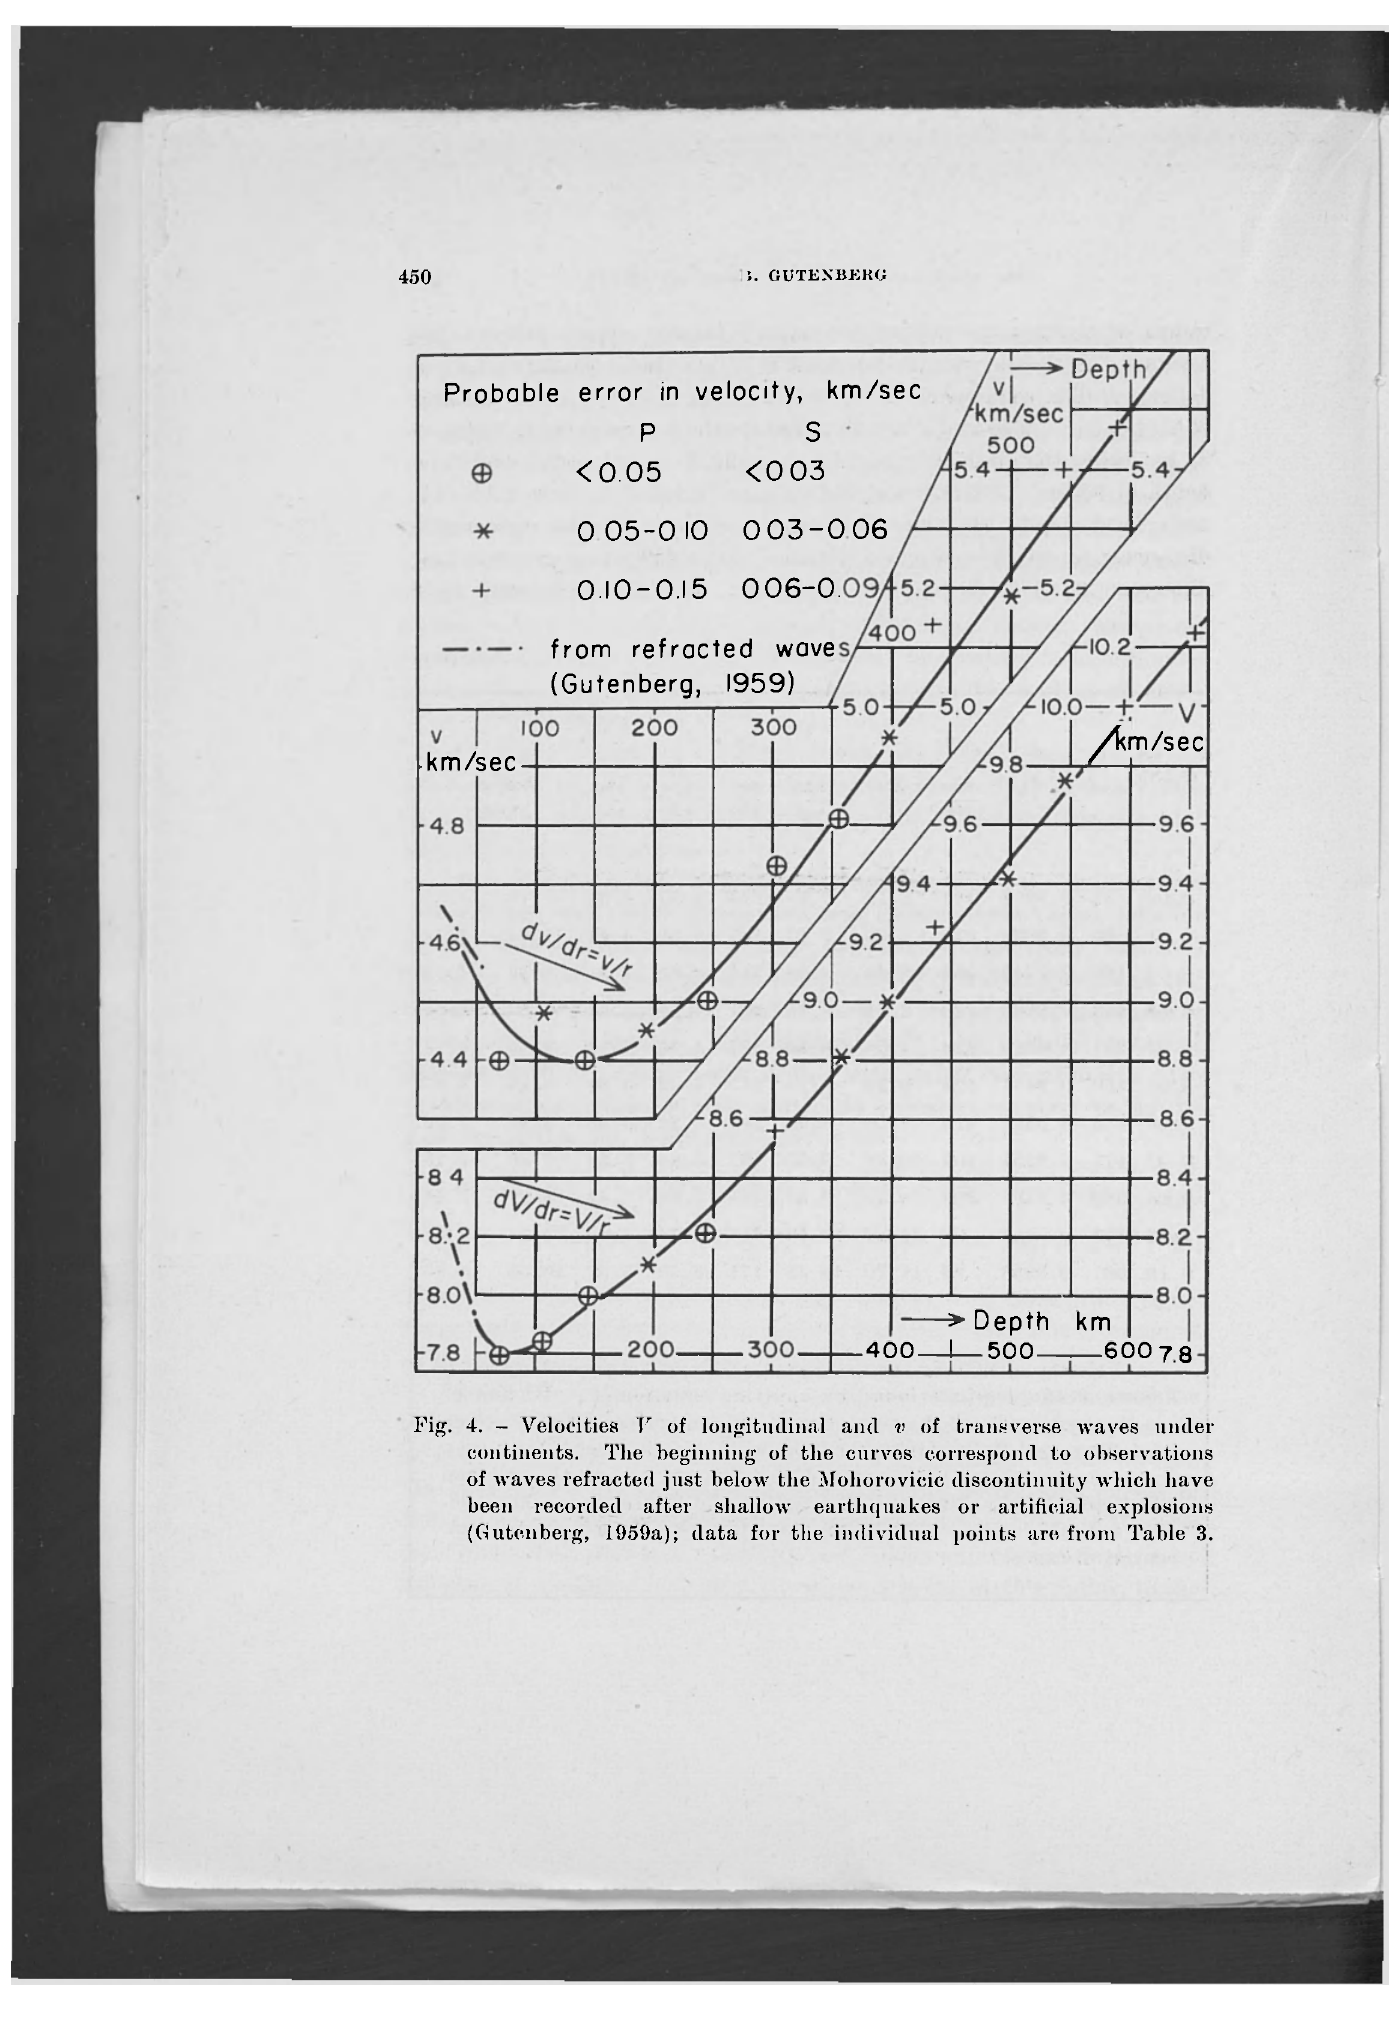
Fig. 4. - Velocities V of longitudinal and v of transverse waves under